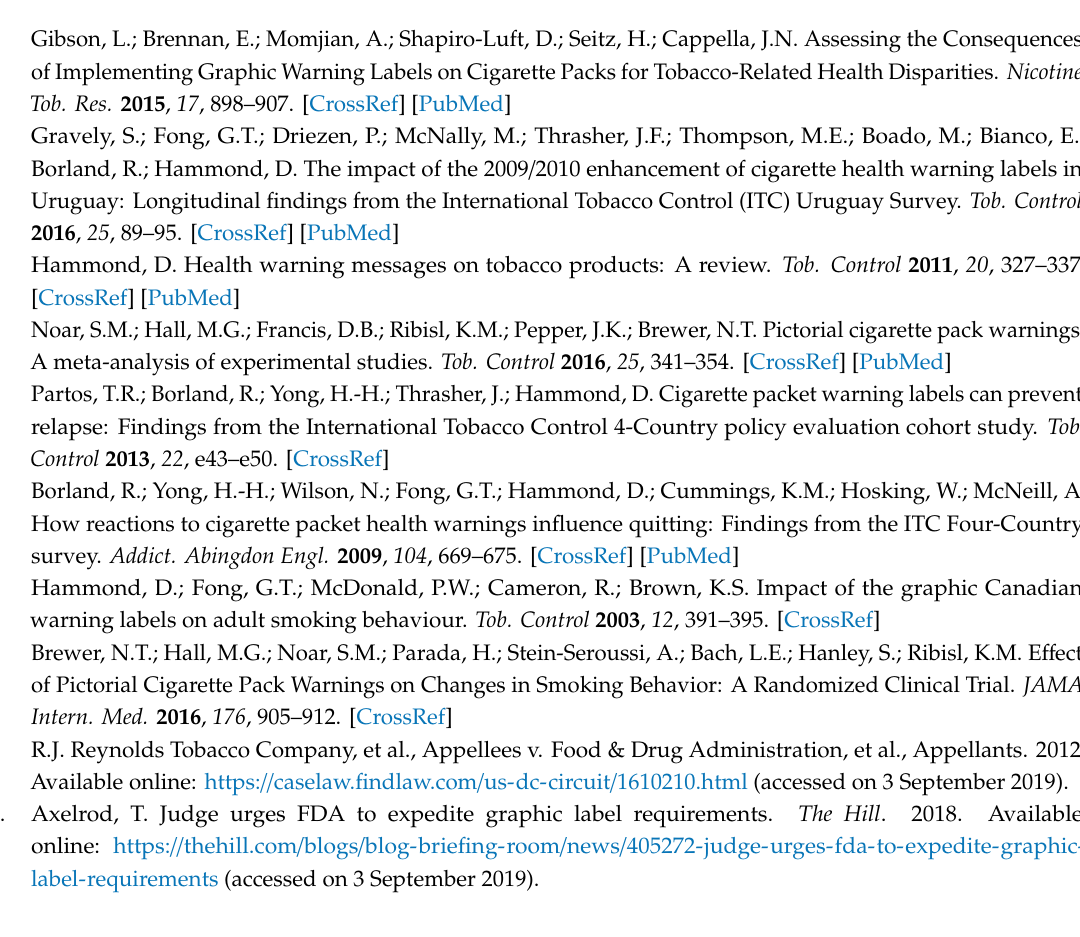
Supplementary Figure S1: Screenshots of graphic warning labels